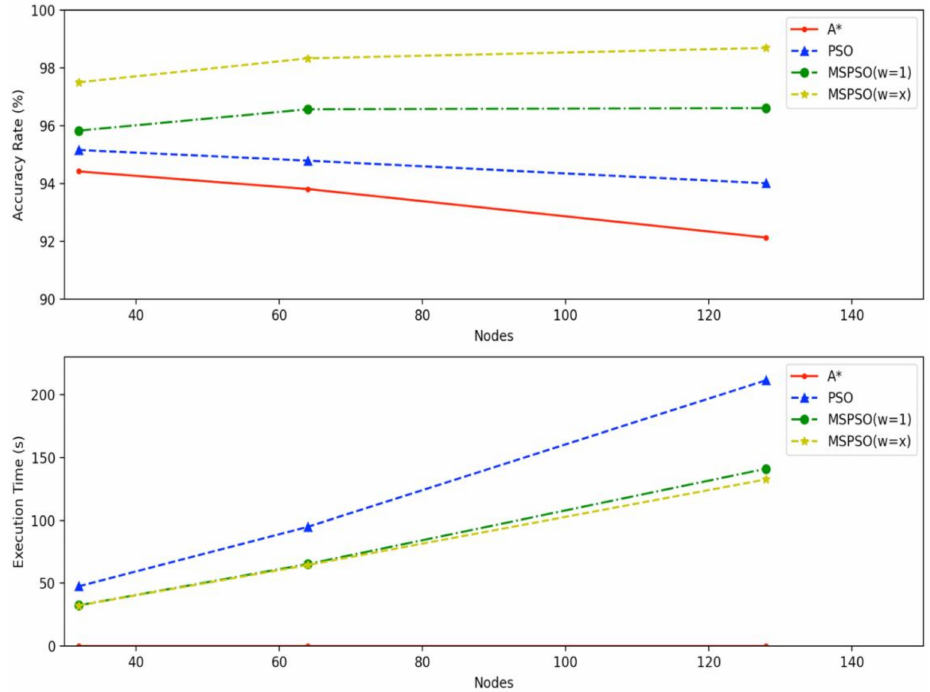
Figure 17. Execution time of route reconstruction for IP traceback using three path-search algorithms. Using the A* search